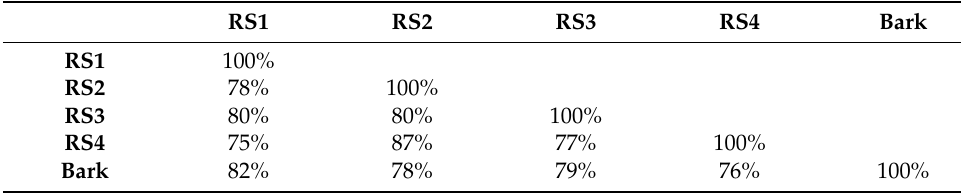
Table 5. Similarity matrix based on the SCoT analysis of the five tomato